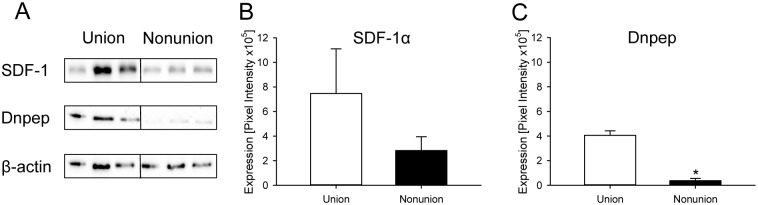
Western blot analyses of callus tissue shows different expression levels for target proteins of miR-140.A: Representative Western blots of SDF-1α, Dnpep, and β-actin expression within the callus tissue of the Union group and the Nonunion group at 7 days after osteotomy. B, C: Quantitative analysis of the expression of SDF-1α (B) and Dnpep (C) within the callus tissue of the Union group (white bars; n = 3) and the Nonunion group (black bars; n = 3) at 7 days after osteotomy. Mean ± SEM; *p < 0.05 vs. Union.